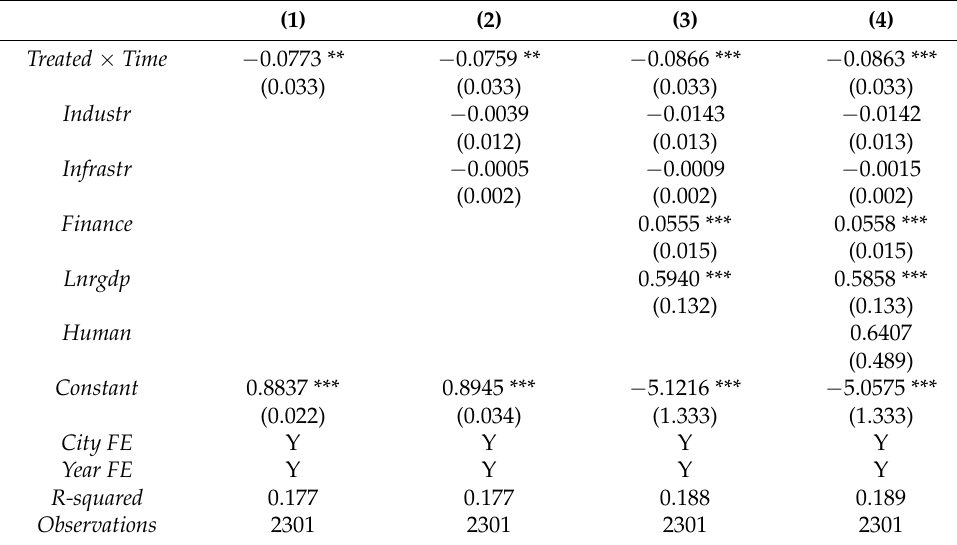
Table 7. Robustness test with the second batch